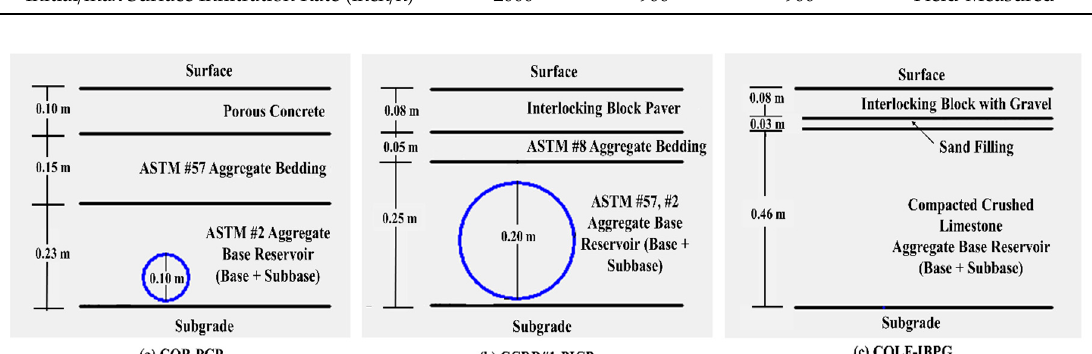
Table 2. Initialization of WinSLAMM model input for permeable pavements subroutine for three different designs.